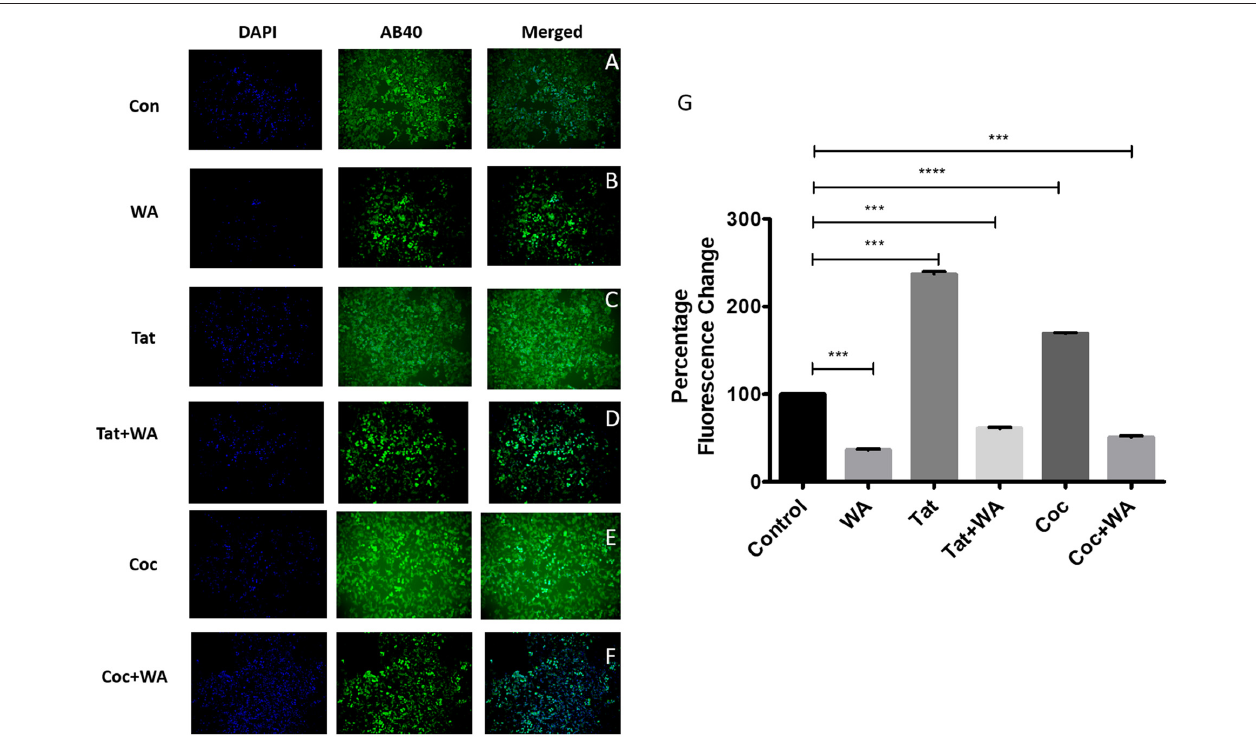
FIGURE 9 | WA inhibits HIV-1 Tat induced A β -production, respectively. SH-APP cells were treated with HIV-1 Tat (50 ng/mL; C ) coc (0.1 µ M; E ) +/ − WA (2 µ M; (D,F) respectively) were compared to Control (A) and only WA treated cells (B) . After 24 h, cells were fixed and stained with Anti-Human A β 40 overnight. Cells were washed and stained with secondary anti-rabbit FITC-labeled antibody (catalog #AP187F, Millipore). Images were acquired using Keyence ALL in one microscope (10 × ). WA significantly suppressed Tat and coc induced A β -secretion, respectively ( n = 3). Florescent intensity of these stained cells was quantified using the ImageJ software ( G ; ∗∗∗ p ≤ 0.001; ∗∗∗∗ p ≤